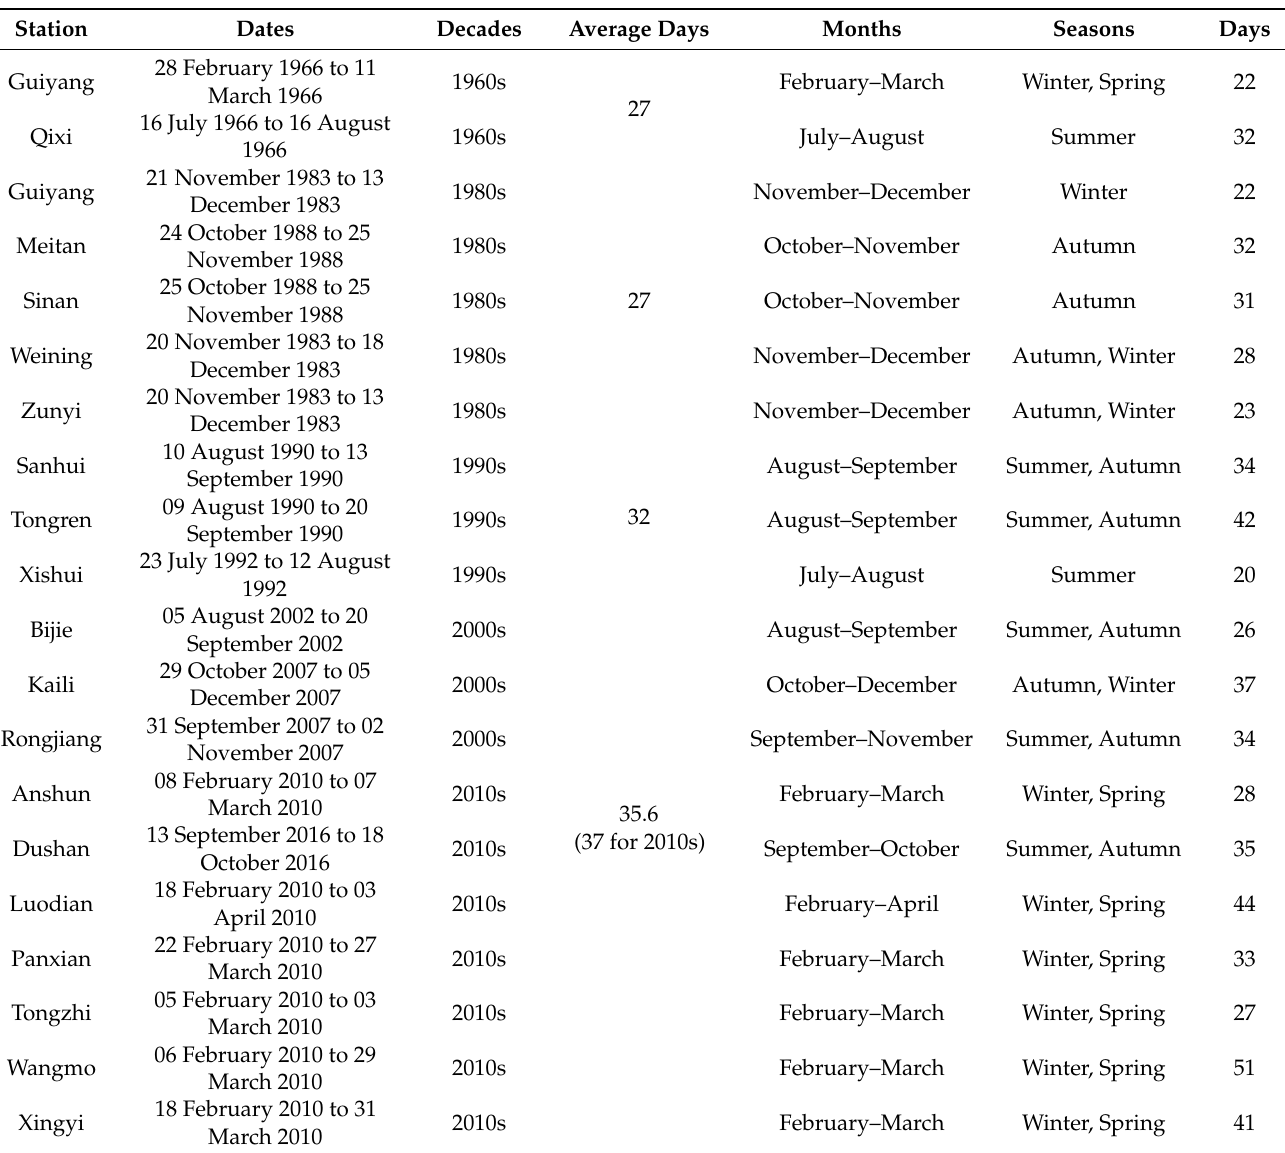
Table 3. Longest Dnp at each